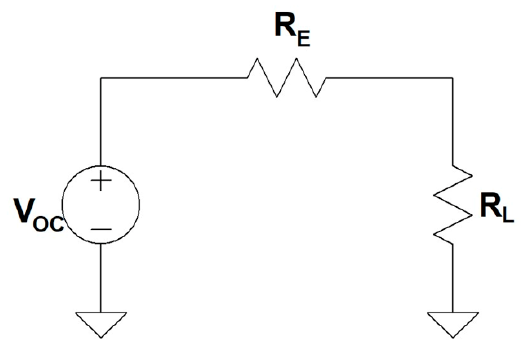
Figure 2. TEG equivalent electrical model.